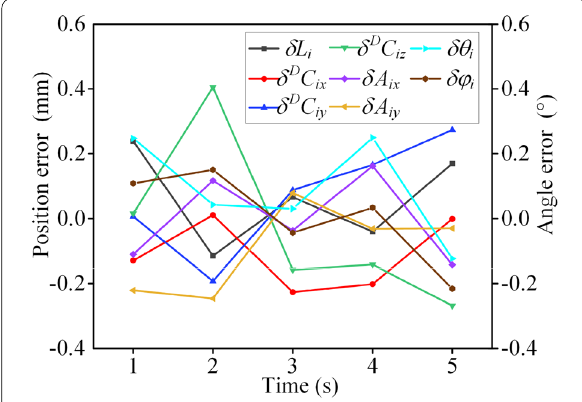
Figure 4 Error calibration